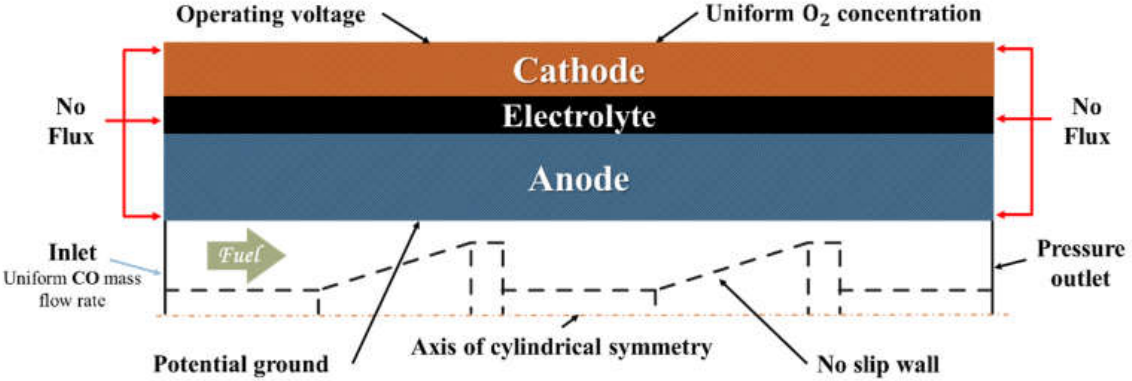
Figure 2. A summary of boundary conditions of the micro-tubular solid oxide fuel cells. Table 2. A summary of parameters used in this study. Parameters Symbols Values Units Ref.